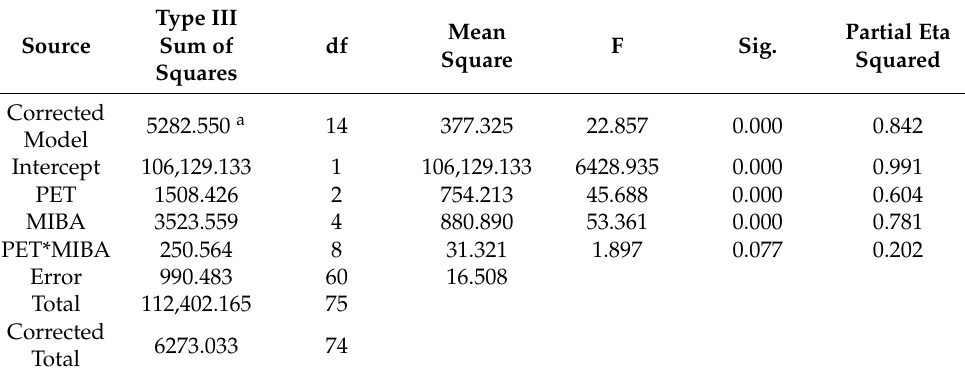
Table 4. Compressive strength tests between PET pellets and MIBA effects. Test of Between-Subjects Effects. Dependent Variable: Compressive